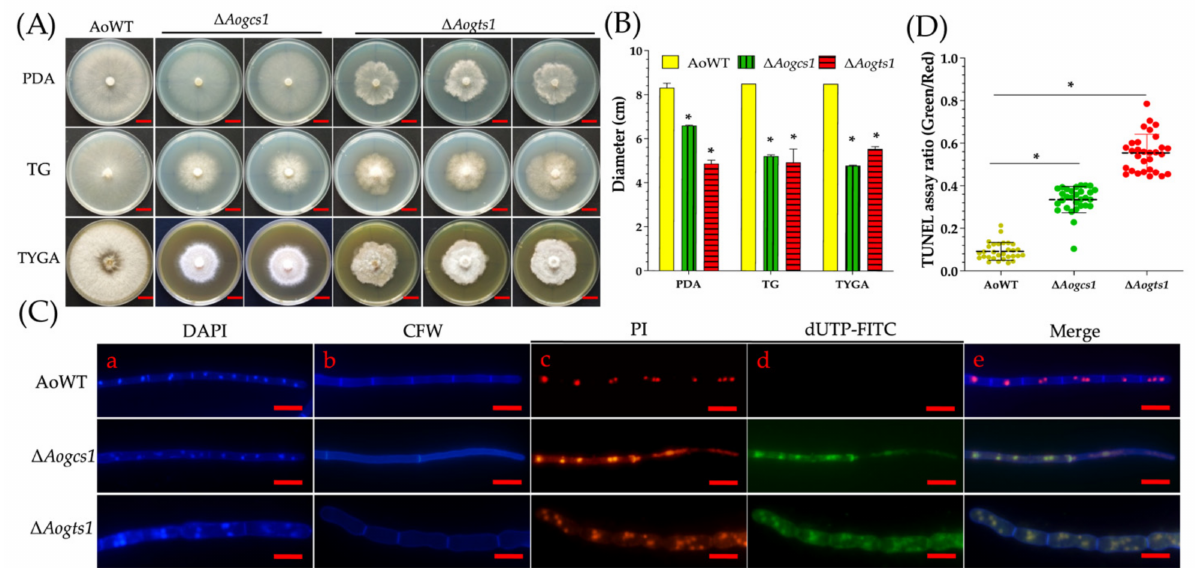
Figure 1. Comparison of colony morphology, mycelial growth, DNA damage, and cell apoptosis in the wild-type (WT) and mutant strains (i.e., ∆ Aogcs1 and ∆ Aogts1 ) of A. oligospora . ( A ) Colonies from the WT and mutant strains were cultured on PDA, TG, and TYGA plates for 7 days at 28 ◦ C. Bar = 2 cm. ( B ) Colony diameters of the WT and mutant strains cultured on different media for 7 days. ( C ) Comparison of nuclei, cell morphology, and DNA damage. ( a , b ) Mycelia were stained with 4 (cid:48) ,6-diamidino-2-phenylindole (DAPI, ( a )) and calcofluor white (CFW, ( b )); ( c ) Nuclei of the hyphae stained with propidium iodide (PI); ( d ) Free DNA of the hyphae re-stained with FITC-dUTP. ( e ) Merged images from panels ( c – e ). Bar = 10 µ m. ( D ) Analysis of DNA fragmentation and cell apoptosis in hyphal cells. The ratio of green to red fluorescence intensity was determined for at least 30 fields observed under a microscope. Asterisk: significant difference between mutant and WT (Tukey’s HSD, p <